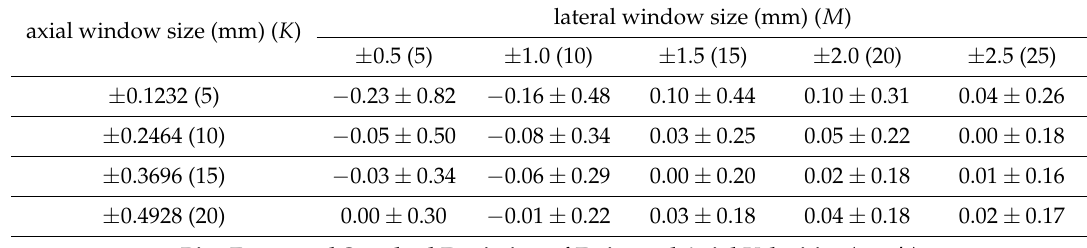
Bias Errors and Standard Deviation of Estimated Axial Velocities (mm/s) axial window size (mm) ( K